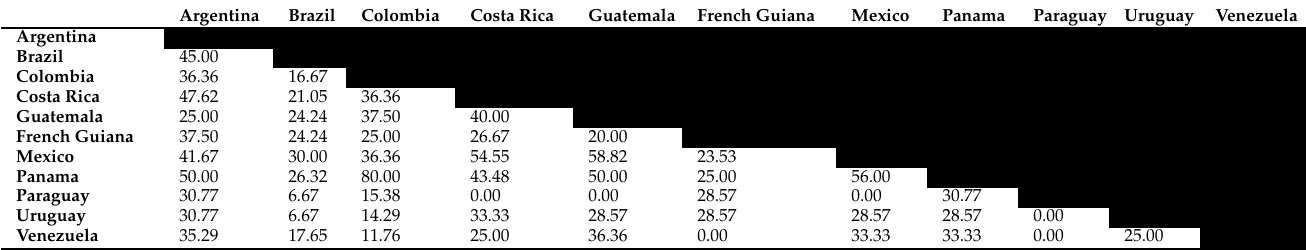
Table 2. Arbovirus similarity index according to Sorensen’s index among Neotropical countries.